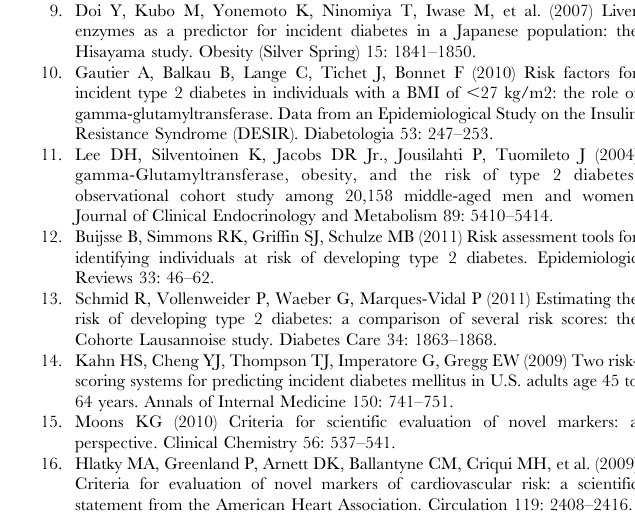
Table S1 Comparison between participants included and participants excluded because of missing baseline leptin or adiponectin data.